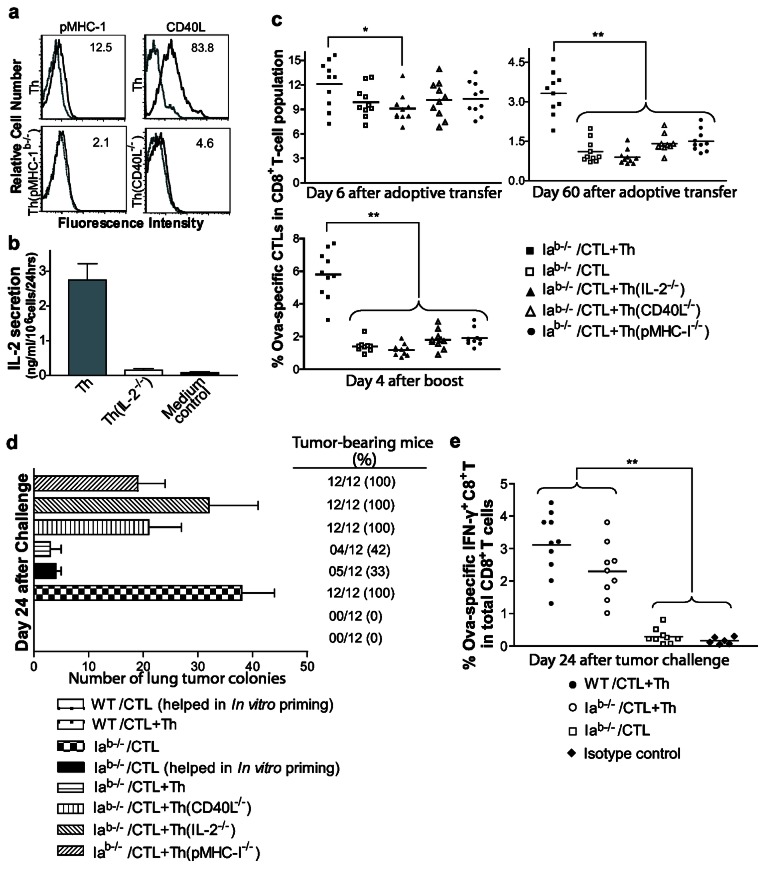
Molecular mechanisms of cognate Th-delivered help responsible for CTL survival and recall responses.(a) DCova(Kb–/–)-stimulated Th(pMHC-I-/-) cells were stained with anti-pMHC I Ab and DCova-stimulated Th(CD40L-/-) were stained with anti-CD40L Ab (solid thick lines; bottom panels) using DCova-stimulated Th cells as a positive control (solid thick lines; top panel). Stained cells were analyzed by flow cytometry. Irrelevant isotype-matched Abs were used as control (dotted thin lines). Value in each panel represents the percentages of positive staining cells versus the control. One representative of two independent experiments is shown. (b) Both Th and Th(IL-2-/-) cells were re-stimulated with OVA323-329-pusled LB27 cells, and IL-2 secretion was assessed in the culture supernatants. The values represent mean%±SD of IL-2 secreted in supernatant and are cumulative of two independent experiments performed in triplicates. (c) Approximately 5x106 effector CTLs were i.v. transferred with or without Th, Th(CD40L-/-), Th(IL-2-/-) or Th(pMHC I-/-) (2x106) cells to CD4+ T cell-deficient mice, and analyzed for survival 6 and 60 days later, and recall responses on the 4th day after boosting. The values represent frequencies of tetramer+ CTLs in total CD8+ T-cell population, and are cumulative of three independent studies with three to four mice per group. The horizontal bars indicate means. * or **, p <0.05 or 0.01, respectively, versus Th cell-helped CTLs in Iab-/- mice. (d) Approximately 5x106 effector CTLs alone that received help during priming period or 5x106 effectors CTLs with or without 2x106 Th cells (i.e., help after CTL priming) were i.v. transferred to WT and Iab-/- mice. In addition, some Iab-/- mice groups were transferred with effectors CTLs with or without effector Th, Th(IL-2-/-), Th(CD40L-/-) or Th (pMHC-I-/-) cells (2x106each) as indicated. After 100 days, all the mice were challenged i.v. with highly metastasizing BL6-10OVA tumor cells. On 24th day of tumor challenge, the numbers of metastasized tumor colonies in lungs were counted and presented as mean%±(SD). The values represent number and percentage of tumor-bearing mice. The data are cumulative of three independent experiments with three to four mice per group. Note: The data of all PBS-injected control mice, which showed >100 tumor colonies, is not shown. (e) Assessment of OVA-specific IFN-γ+ CTLs in the spleen of tumor-challenged mice. Approximately 5x106 effector CTLs with Th cells (2x106) or without Th cells were adoptively co-transferred into WT or CD4+ T cell-deficient mice. Hundred days later, all the groups were challenged with BL6-10OVA tumor cells. On 24th day of tumor challenge, the spleen samples were analyzed by intracellular IFN-γ+ staining to assess CTL-mediated tumor protection. The data represent cumulative frequencies of ova-specific IFN-γ+ CTL in total CD8+ T cell population. **, p < 0.01 versus unhelped CTLs in Iab-/- mice. One representative of the three independent experiments with three to four mice per group is shown.